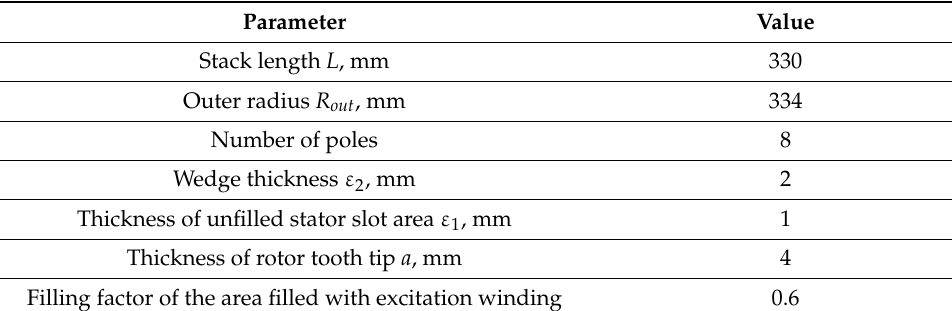
Table 2. WRSM parameters fixed during optimization.